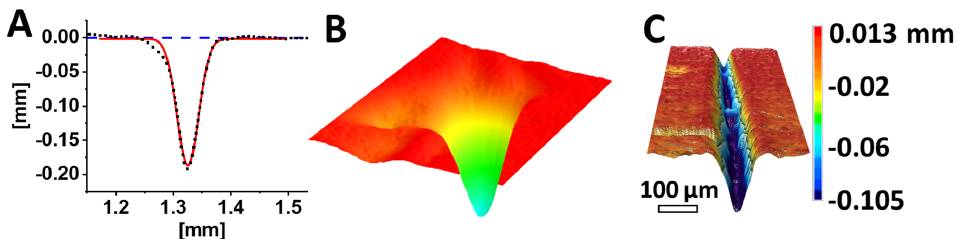
Figure 6. Gaussian profile of the Ti:Sapphire femtosecond laser ablation spot on the chondritic meteorite Dho 1709 ( panel A ). Intensity profile of the femtosecond laser employed ( panel B ). Sectional view of the ablation incision on the chondritic meteorite Dho 1709, obtained via profilometry ( panel C